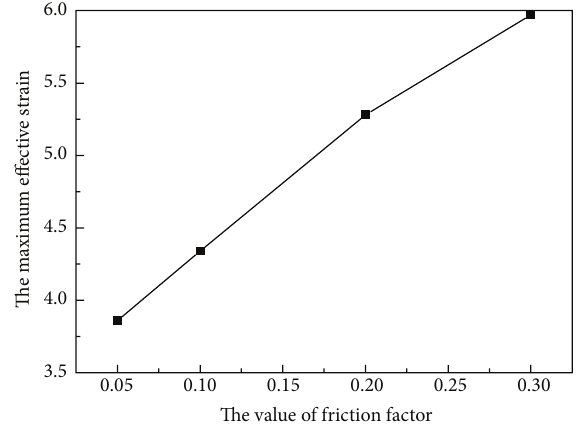
Figure 3: The maximum effective strain with different friction